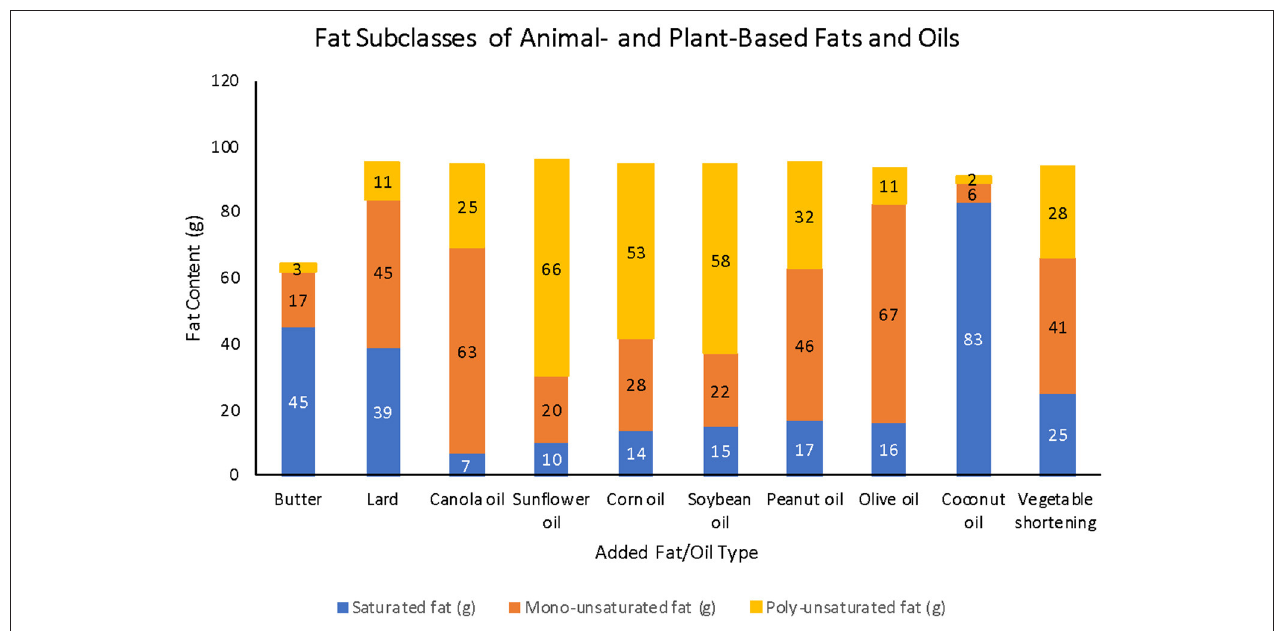
FIGURE 7 | Fat subclasses of various animal- and plant-based fats and oils (Source: USDA Food Central Data ).